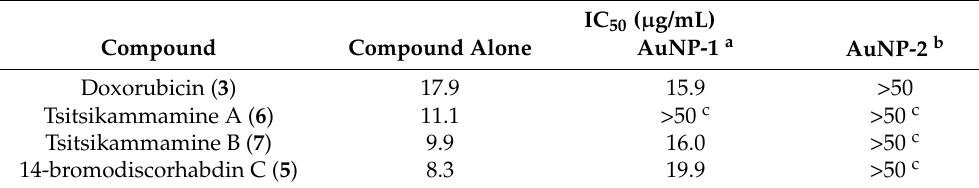
Figure 8. Cytotoxicity of doxorubicin ( 3 ), 14-bromo discorhabdin C ( 5 ) and the tsitsikammamines ( 6 and 7 ) alone, their as-synthesized sAuNP conjugates (NP) and the mixture (NP(m)) against the MCF-7 cancer cells. Dose: 1.5 μ g/mL to 50 μ g/mL. Graphs are labelled ( A ) doxorubicin ( 3 ) and conjugates, ( B ) 14-bromo discorhabdin C ( 5 ) and its conjugates, ( C ) Tsitsikammamine A ( 6 ) and its conjugates, ( D ) Tsitsikammamine B ( 7 ) and its conjugates. Table 3. IC 50 values of compounds 3 , 5 – 7 and their sAuNP conjugates, as well as their mixtures (m) of bound and unbound AuNP conjugates, against MCF-7